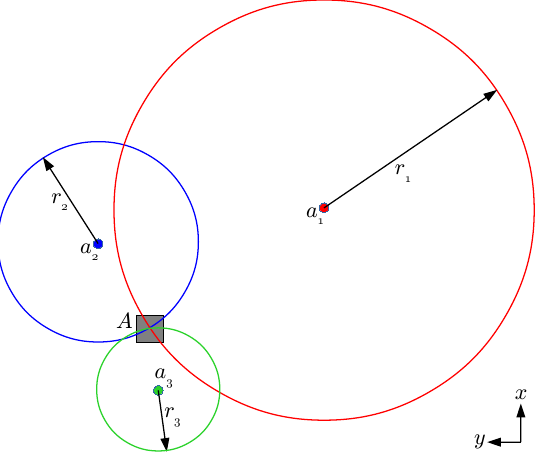
Figure 3. Trilateration example for the 2D case. The intersection of the three circumferences with radius r 1 , r 2 and r 3 , respectively centred at the anchors ( a 1 , l 1 ) , ( a 2 , l 2 ) and ( a 3 , l 3 ) , is used to compute the position of the tag situated at point A